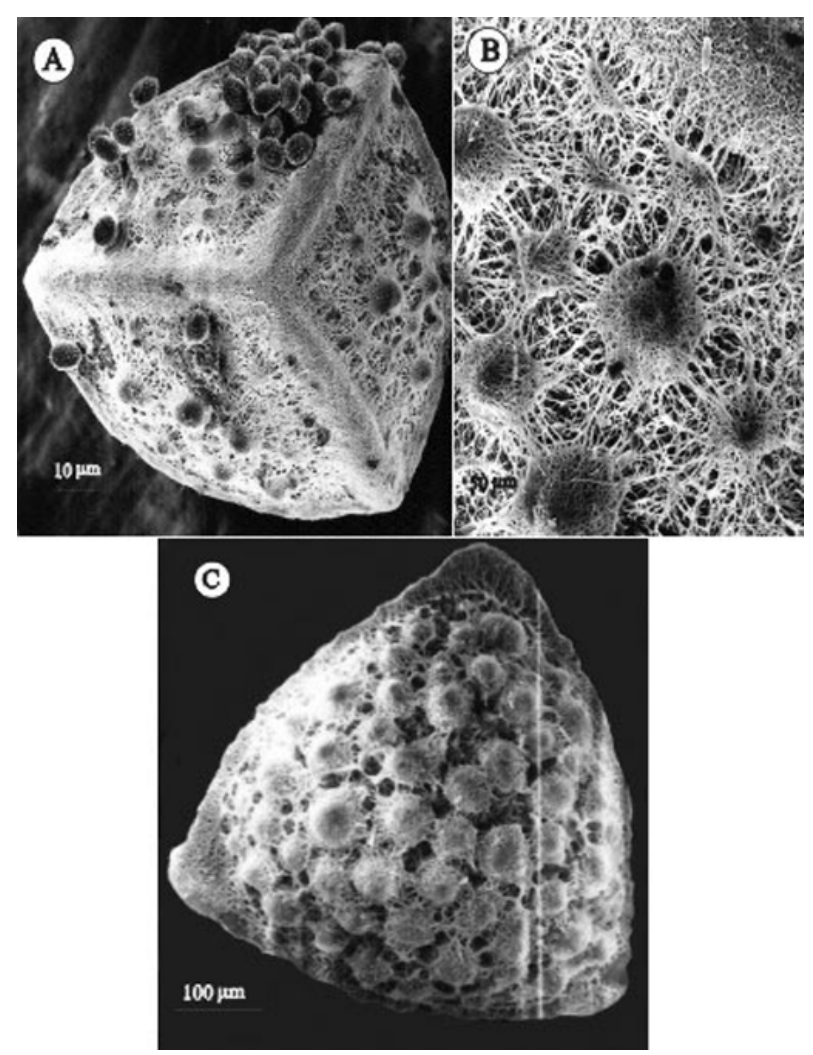
Fig. 2 – Isoetes pedersenii . A-C. Megaspores observed with SEM. A – Proximal view. The laesurae join in the equatorial zone or cingulum. Microspores are observed on the megaspore surface. B – Detail of the proximal structure showing tubercles of different diameter. C – Distal View. ( Pedersen 8105 ,